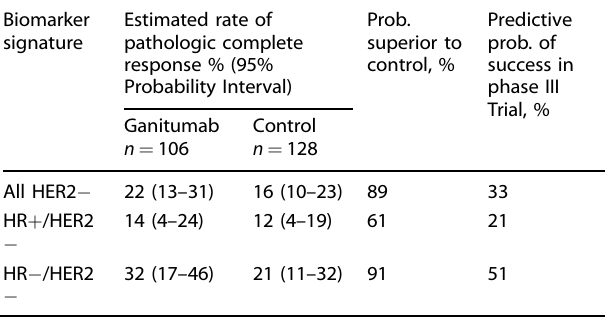
Table 2. Final predictive probabilities of success of ganitumab and metformin with paclitaxel followed by anthracyclines in HER2 − biomarker signatures. The combination failed to graduate in any of the three signatures.